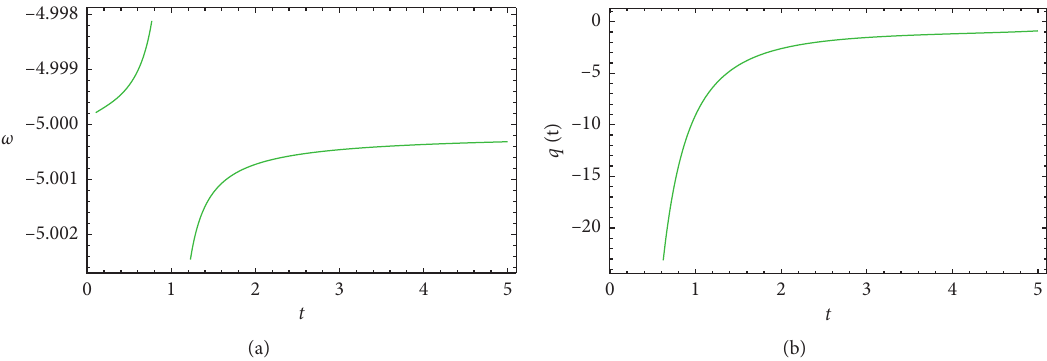
Figure 11: Evolution of EoS and deceleration parameters with α � 0 . 2222 ; κ � 0 . 0256 ; ζ � 0 . 5 ; ξ � 0 . 5 ; β � − 0 . 04858 ; λ � 0 . 5 ; r � − 0 . 0005 ; s � 5.